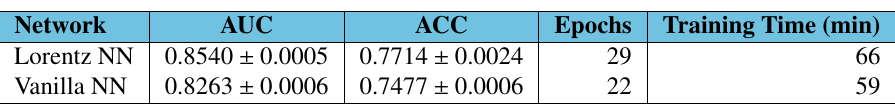
Table 1. Summary of Lorentz and Vanilla network performances. All values are averaged across 10 training runs, and error bars are the sample standard deviation of the 10 values. AUC is area under the receiving operator characteristic curve, and ACC is the accuracy measurement with a threshold of 0.5.